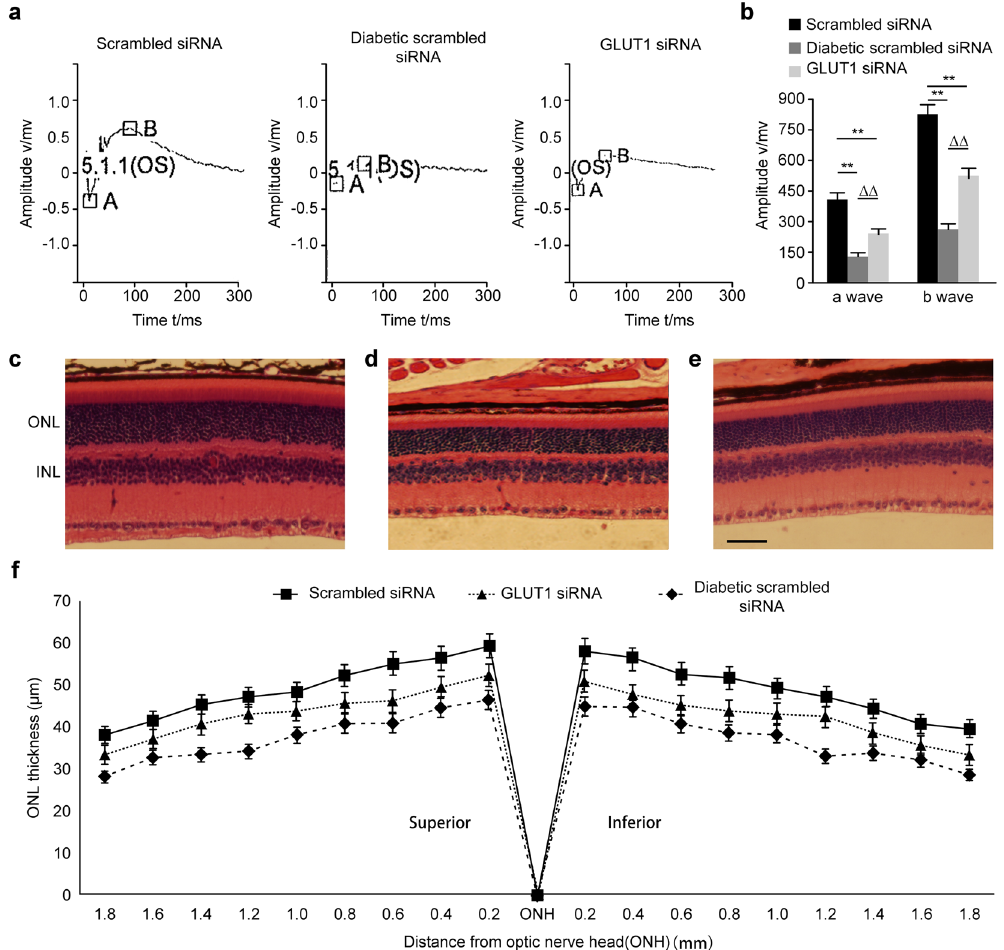
Figure 3. ( a ) Representations of classic scotopic ERG waveforms. Figure 3b: Results of the statistical analysis of scotopic ERG a wave and b wave amplitudes ( n = 9) ** P < 0.01, compared with scrambled siRNA group, ΔΔ P < 0.01, compared with diabetic scrambled siRNA group. Figure 3c–f: ONL thicknesses of the three groups (inverted microscope × 400) ( d ) scrambled siRNA group; ( e ) diabetic scrambled siRNA group, scale bar represents 50 μ m; ( f ) GLUT1 siRNA group; ( f ) Statistical analysis of ONL